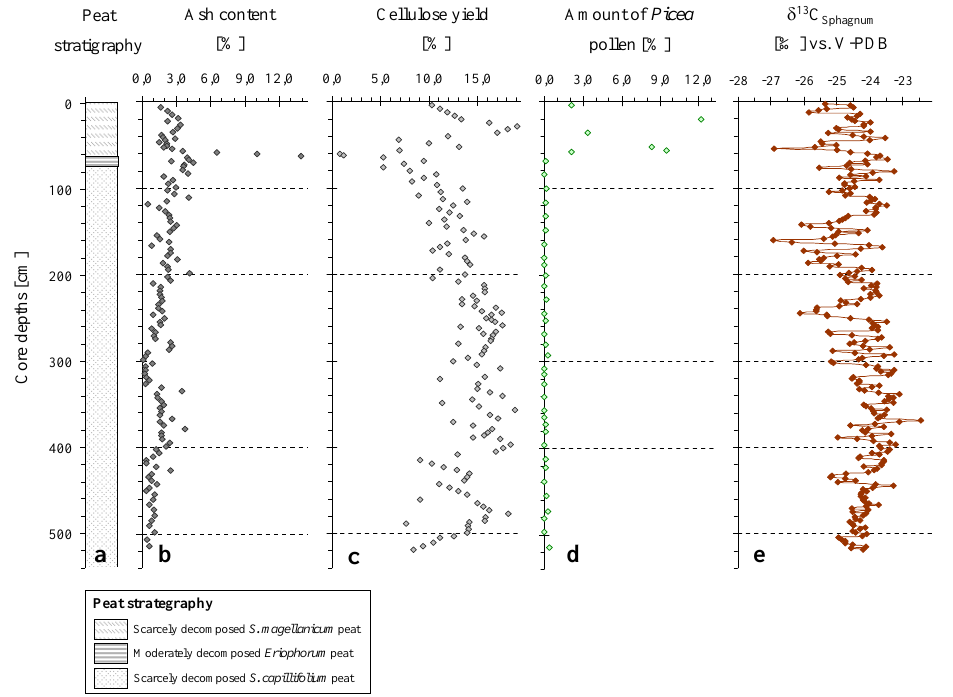
Fig. 3. The stable carbon isotope composition of Sphagnum cellulose (e) in combination with the peat stratigraphy of the upper ∼ 5.2m of core DM-01 (a) , the ash content of the bulk peat material (b) , the cellulose content of Sphagnum leaves (c) , and the Picea pollen concentration (d) of selected samples from core DM-01. No error bars are added to the individual symbols of figure (e) because the overall precision of replicate analyses is better than ± 0.1‰ and the error bars, thus, would be smaller than the symbol